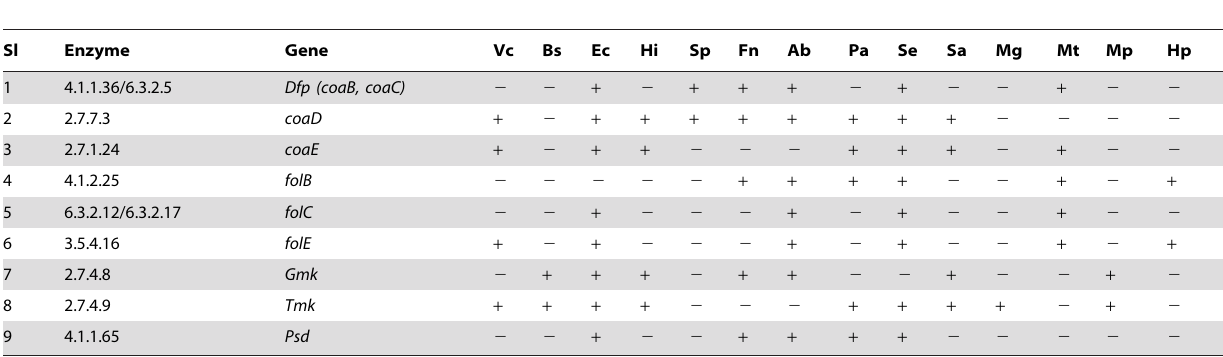
Table 4. Comparisons of predicted essential enzymes encoding genes shared by all three Category A agents to experimentally identified essential genes across various pathogenic bacteria.